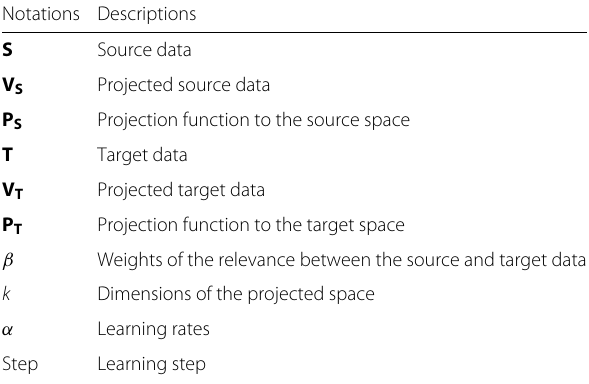
have the same dimensions. The notation description are presented in Table